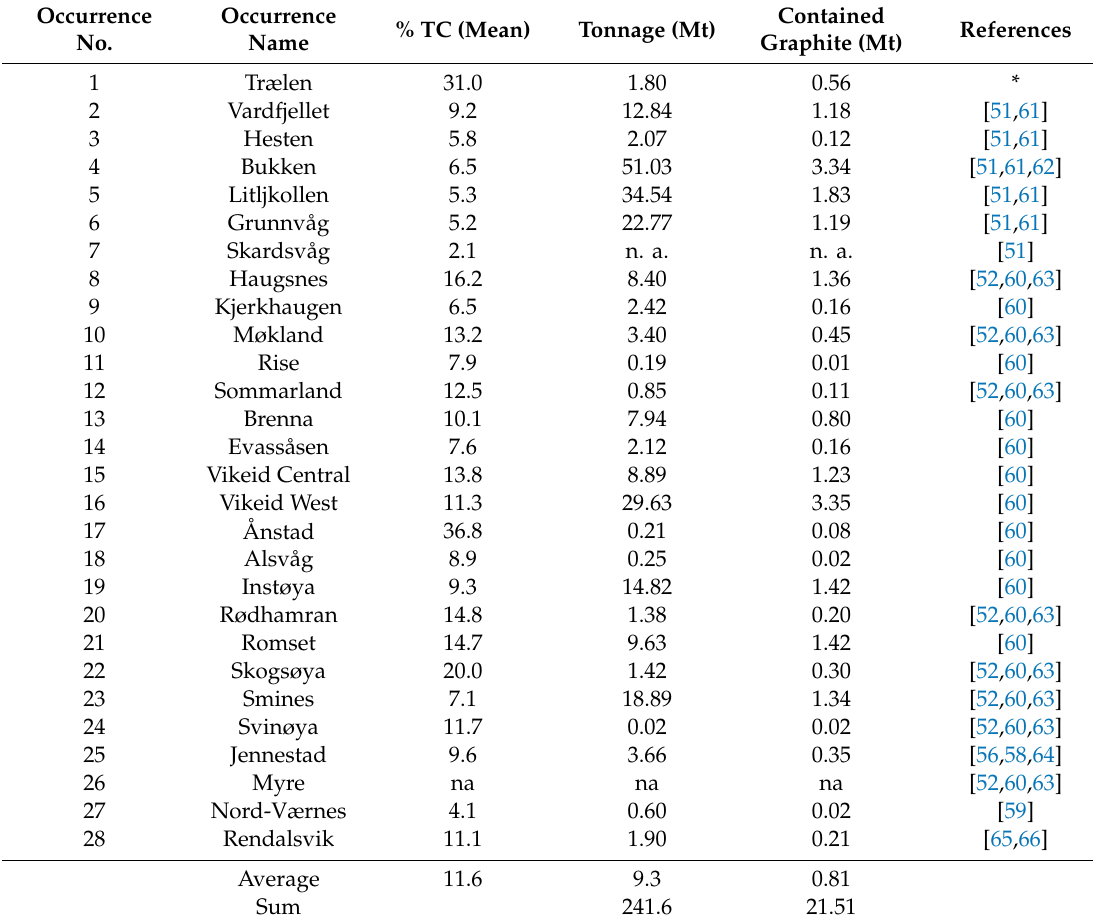
Table 1. Investigated graphite occurrences, their average total carbon (TC) content (Wt. %), estimated tonnage, and calculated contained graphite. See the text for the approach used for calculating tonnages and contained graphite